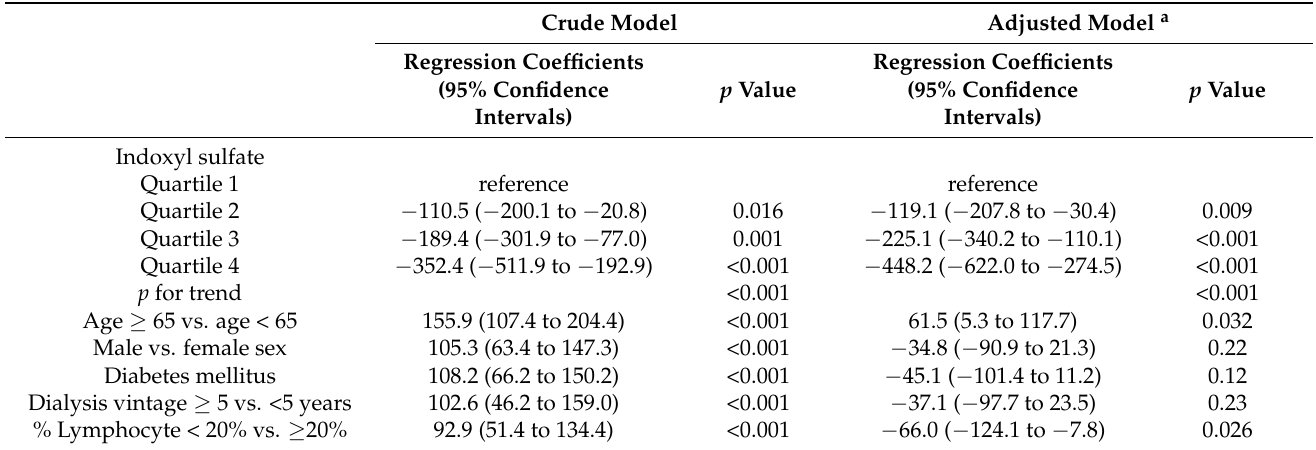
Table 2. Associations between anti-S1 IgG and indoxyl sulfate levels at 4 weeks after the 1st dose of the ChAdOx1 vaccine in patients undergoing hemodialysis.